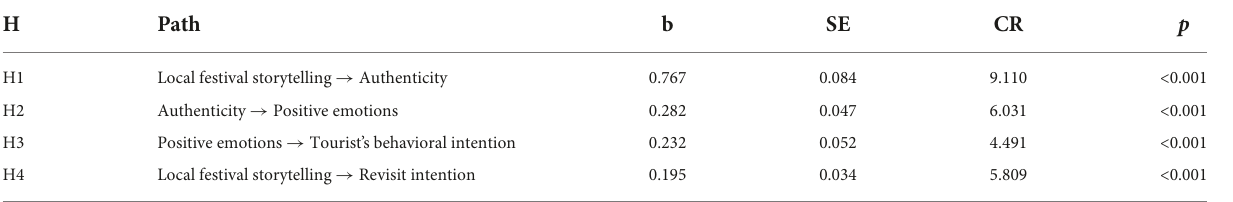
TABLE 2 Path analysis results.